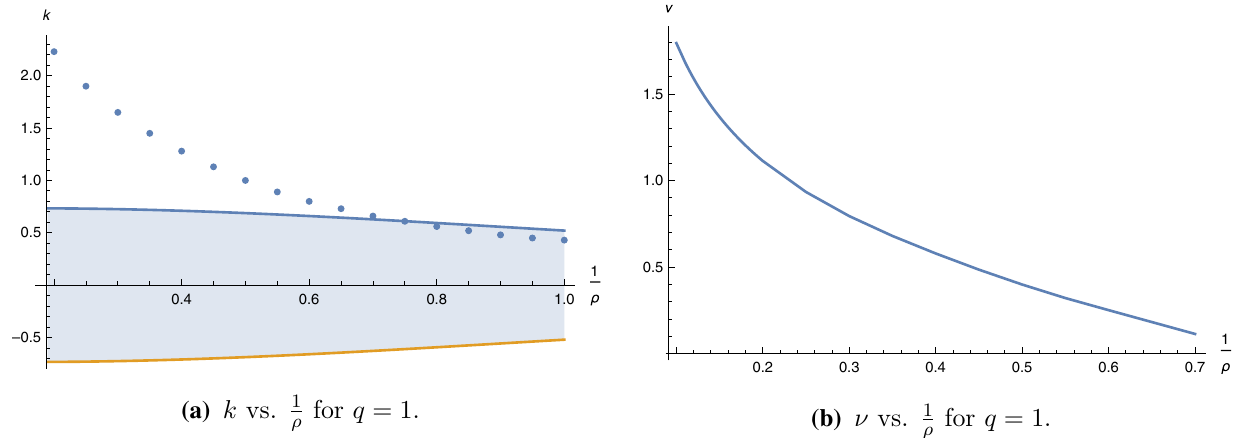
Fig. 2 The shaded region on the left figure corresponds to the oscillatory region, with blue dots representing the Fermi momenta ( k F )for q = 1. On right we have ν vs. 1 /ρ plot, where the quasiparticles start becoming stable with a higher value of charge density